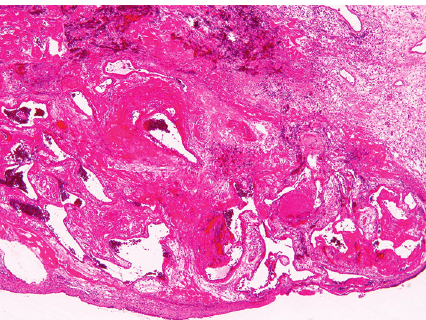
Figure 3: Histopathological analysis of specimen using hematoxylin and eosin (H&E) stain × 40. The H&E sections show dilated vascular spaces that are lined by endothelial cells without significant atypia.